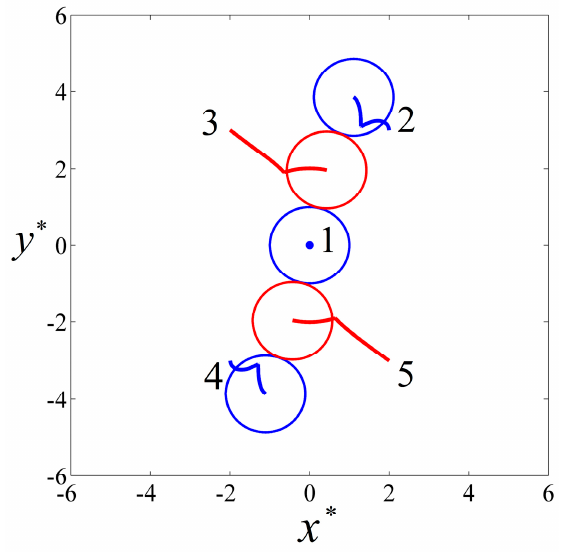
Figure 8. The particle trajectories and the final positions of five particles under a perpendicular AC field with (cid:101) E 0 = 0.02 and f = 10 3 Hz. The blue and red colors denote pDEP and nDEP particles, respectively.